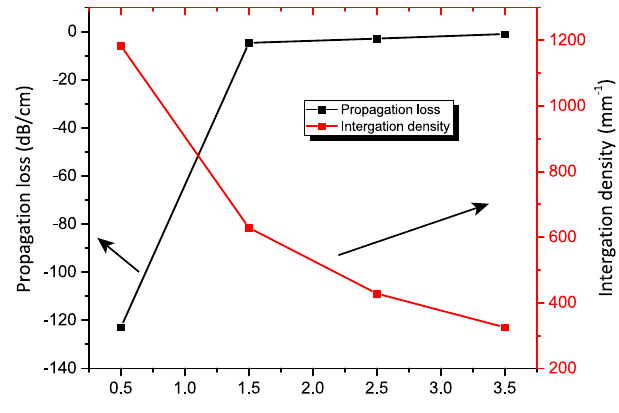
Figure 4. Propagation loss and integration density versus the column number of triangular lattice air holes waveguides at the wavelength of 1.55 µ